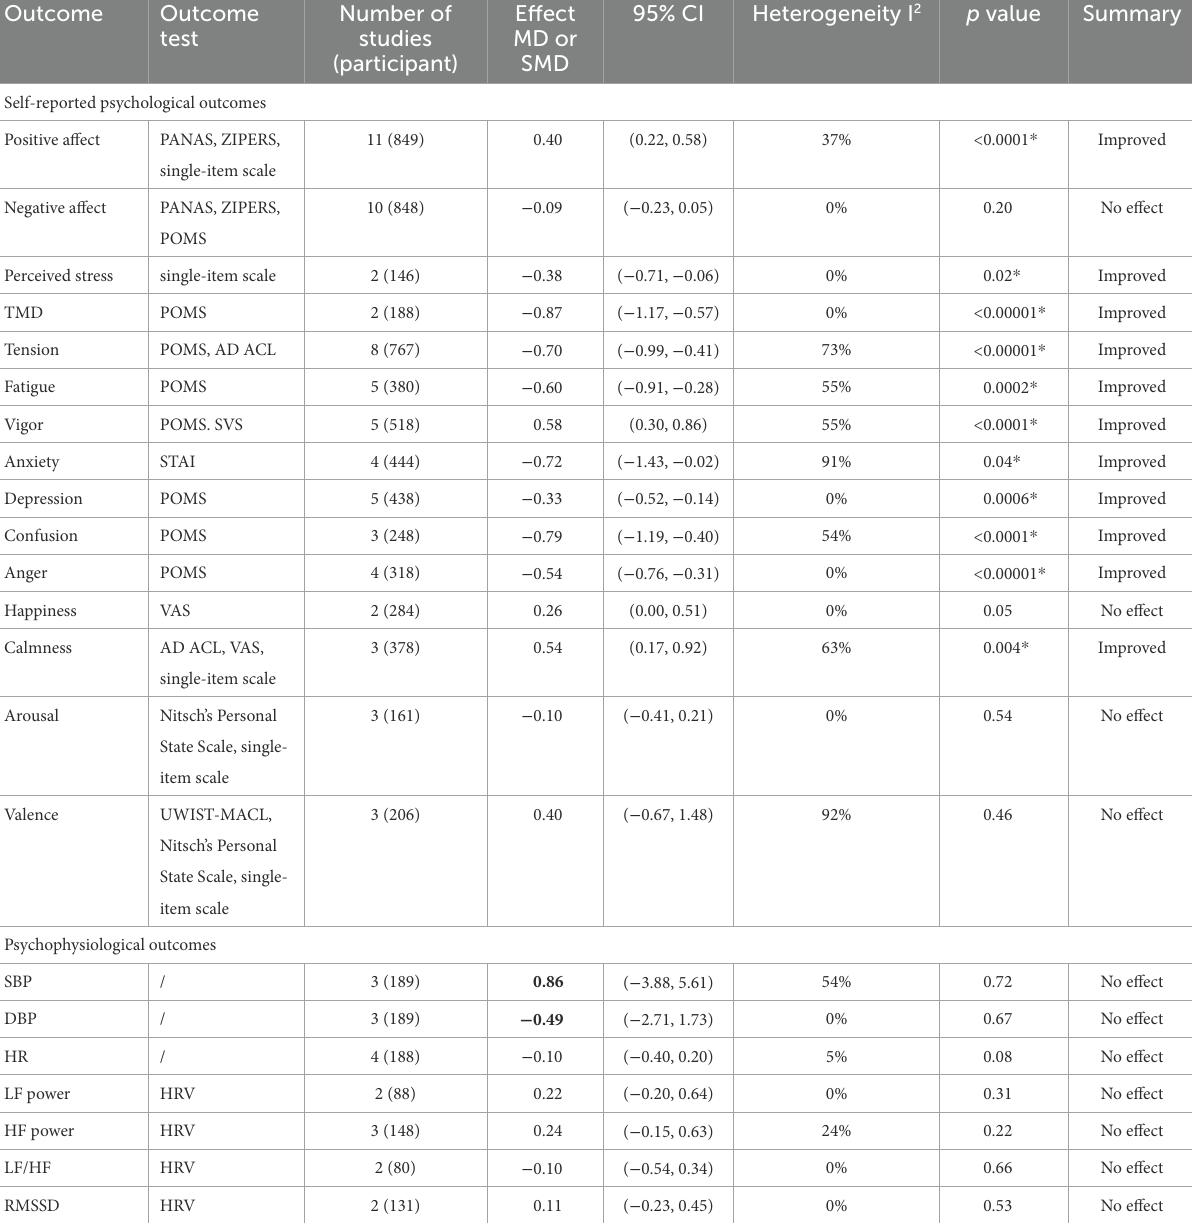
TABLE 2 Summary meta-analysis results table: the pooled effect sizes between simulated nature and non-nature exposure